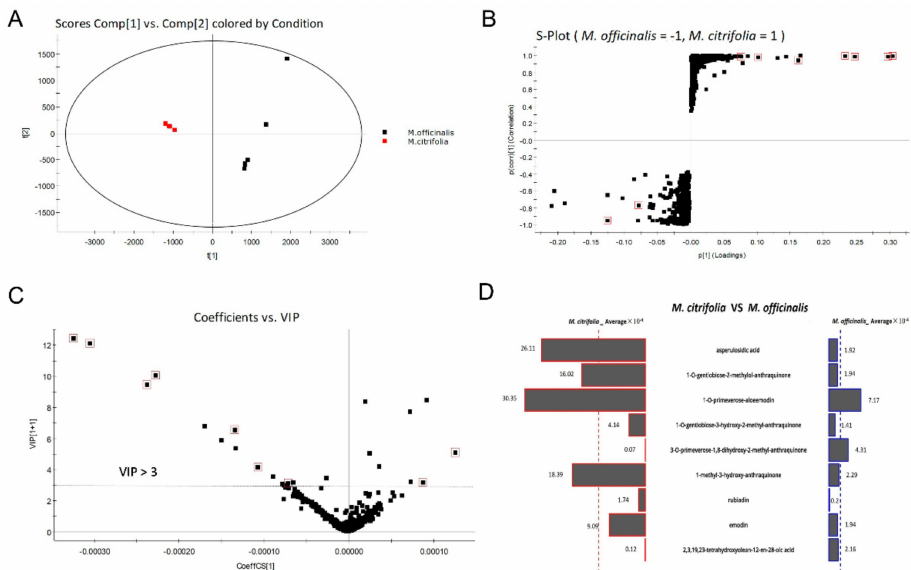
Figure 5. Selected potential biomarkers from M. o ffi cinalis and M. citrifolia based on principal component analysis (PCA) and orthogonal partial least squares-discriminant analysis (OPLS-DA). ( A ) PCA score plot; ( B ) S-Plot from OPLS-DA of M. o ffi cinalis and M. citrifolia . ( C ) The variable importance in projection (VIP) score of selected markers; ( D ) Butterfly shows the variable averages by group of selected potential marker compounds. The most di ff erential compounds are marked with a red